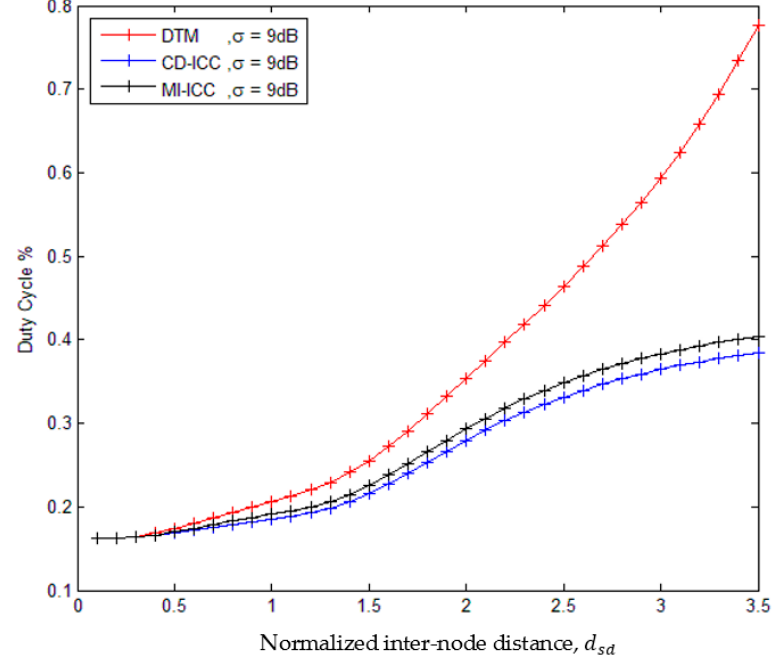
Figure 7. Comparison of Duty cycle of DTM, MI-ICC [34] and CD-ICC with normalized inter-node distance, d sd . In all cases, the ρ is 3.5, T sleep is 25 s , ξ min is 6 and ξ max is 7.